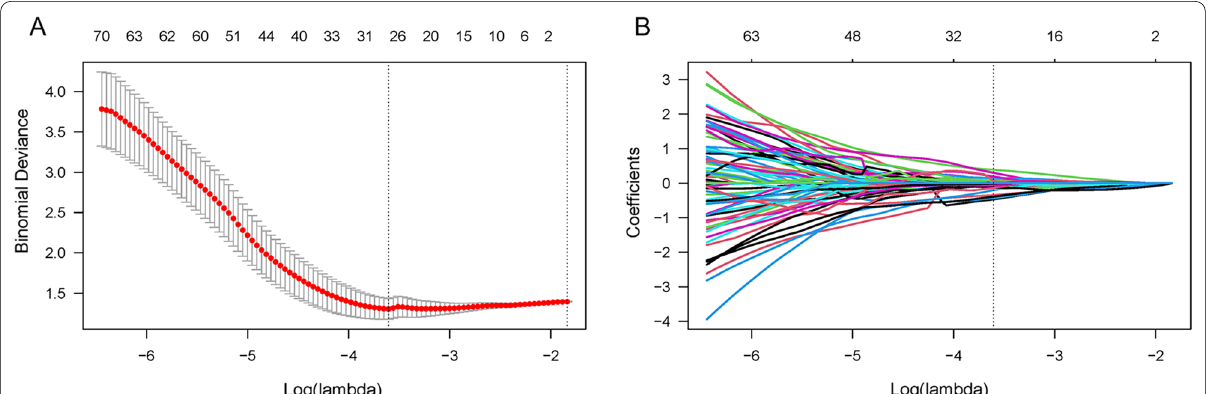
Fig. 3 Radiomics feature selection using the least absolute shrinkage and selection operator (LASSO) regression. A The tuning parameter lambda (λ) in the LASSO regression model was selected via five-fold cross-validation based on minimum criteria. The LASSO regression model shows the best predictive performance when the λ value was set as 0.027167 and log(λ) was 3.605761, at which point 25 features were selected. B The − dotted vertical line was plotted at the selected λ value, resulting in 25 non-zero-coefficient features